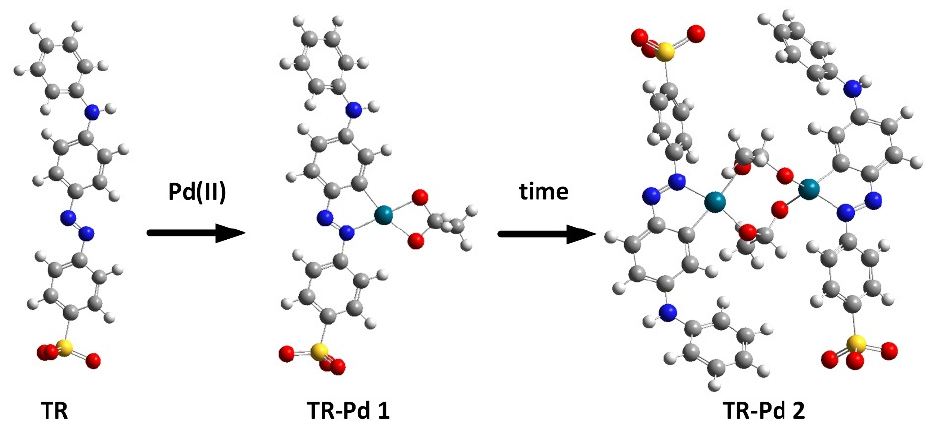
Figure 4. Optimized structure during process of metalorganic complex formation between Pd and tropaeolin OO. Red—oxygen; yellow—sulfur; dark green—palladium; grey—carbon; white—hydrogen, blue—nitrogen.